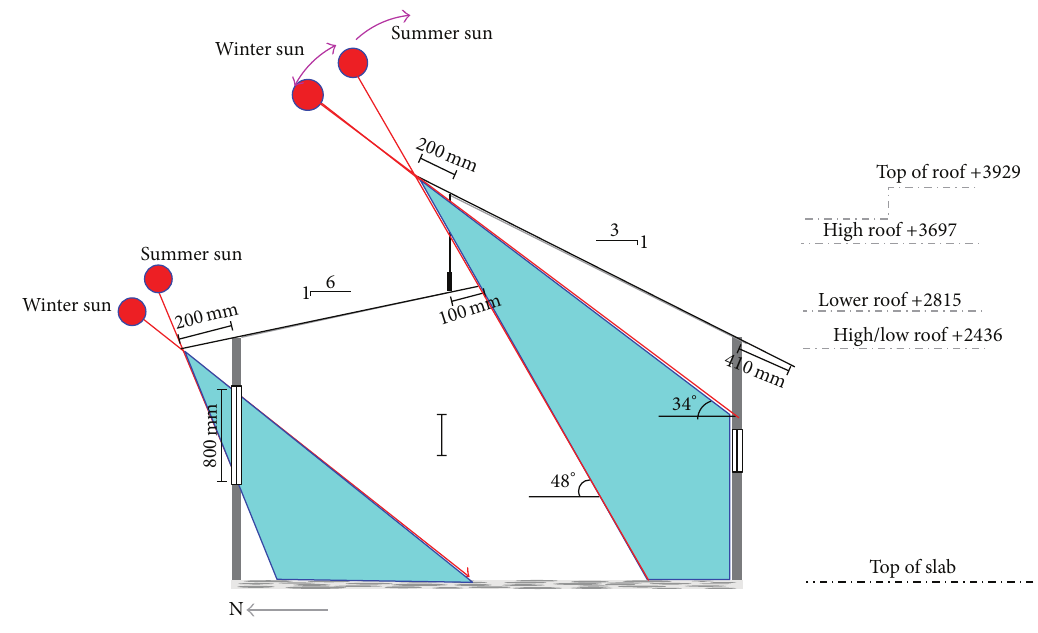
Figure 3: Operation of the passive solar house.